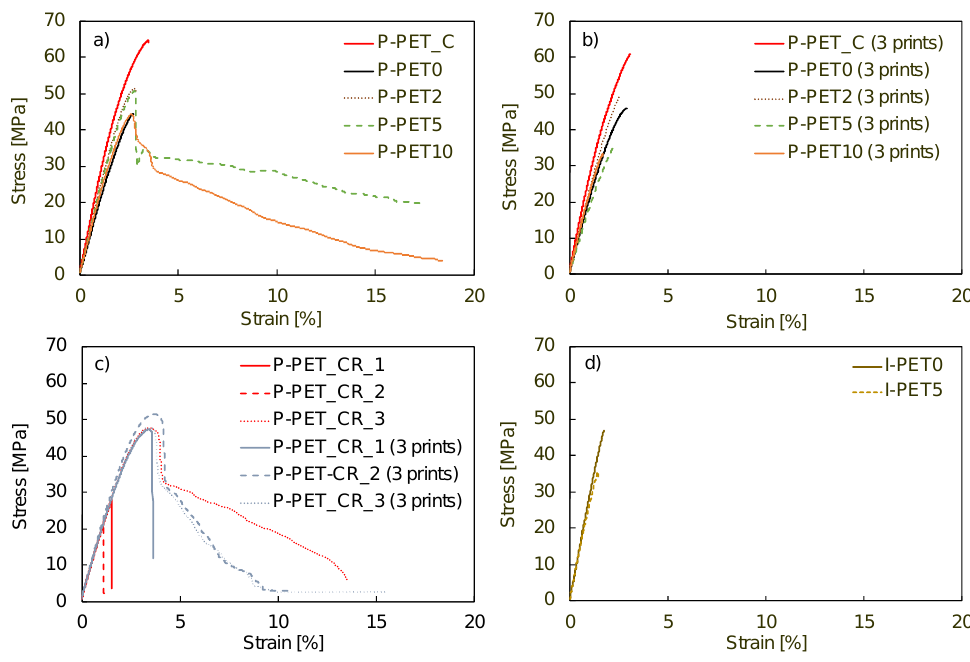
Figure 3. Stress-strain curves of ( a ) single prints, ( b ) three prints, ( c ) prints of commercial recycled filament (single prints and three prints), and ( d ) injected specimens. Table 3. Young’s modulus and maximum tensile stress for printed and injection-molded HDPE-PET